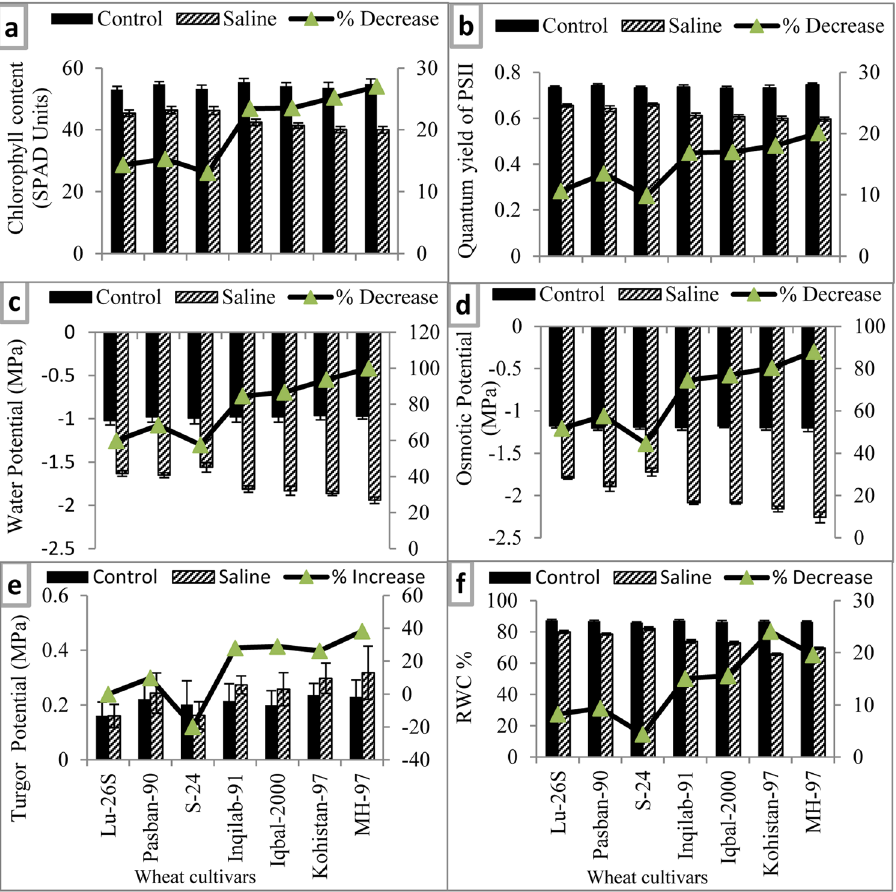
Figure 4. Photosynthetic attributes and water relation parameters of selected salt tolerant and sensitive wheat cultivars at adult stage when plants of each cultivar were subjected to 0 or 150 mM NaCl salinity stress. Means are presented on primary vertical axis, while percent increase/decrease value is presented on secondary vertical